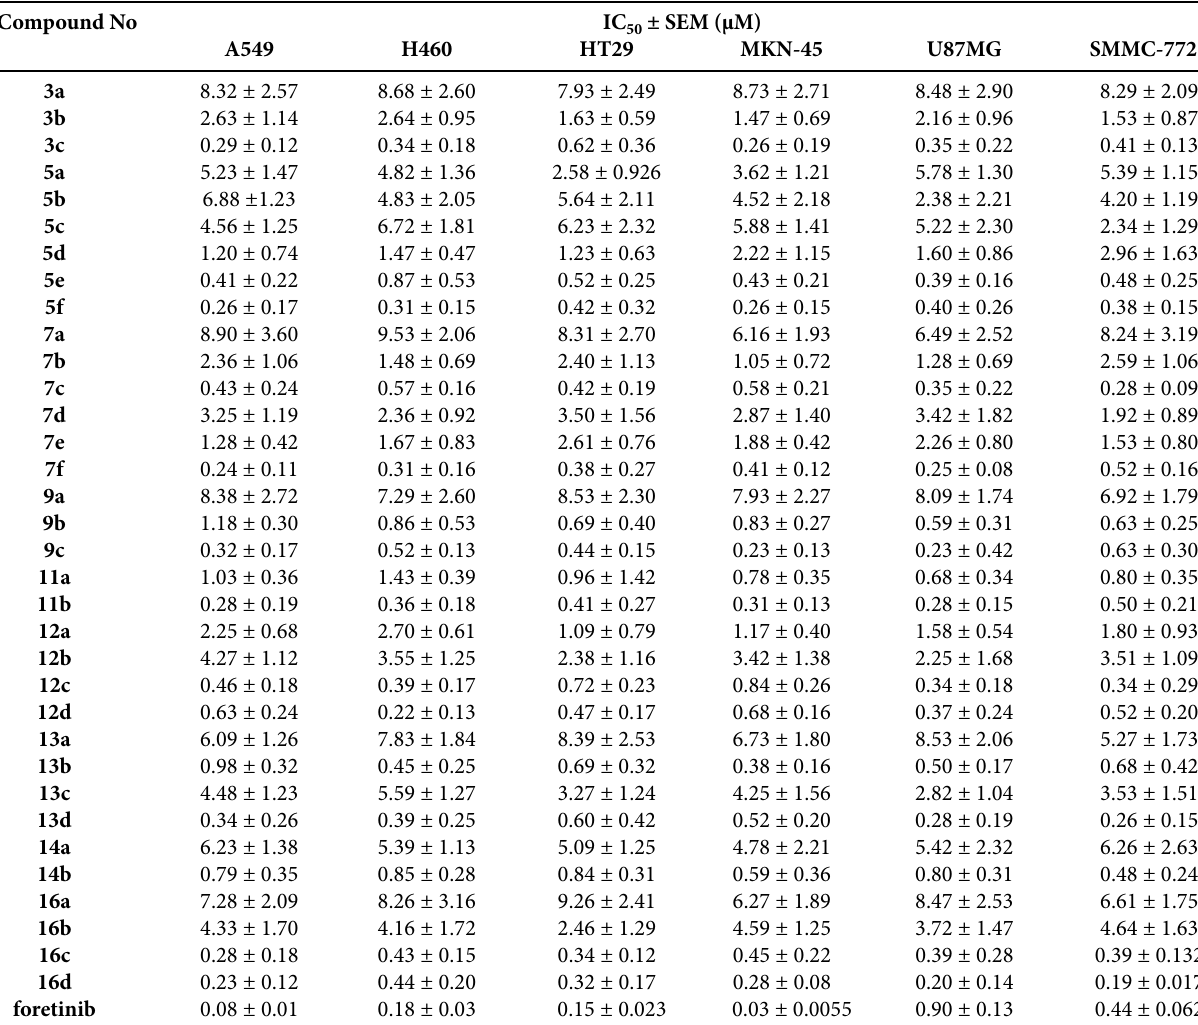
Table 1. In vitro growth inhibitory effects IC 50 ± SEM (μM) of the newly synthesized compounds towards cancer cell lines Compound